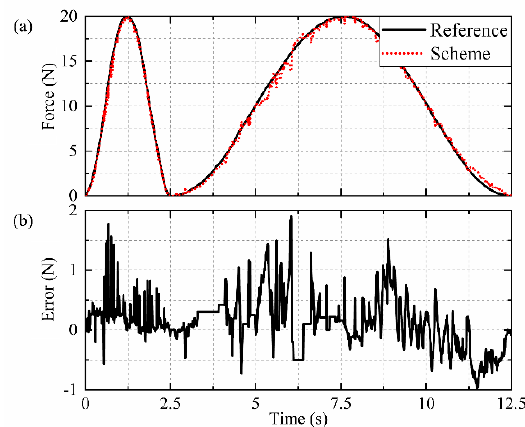
Table 5. System parameters.